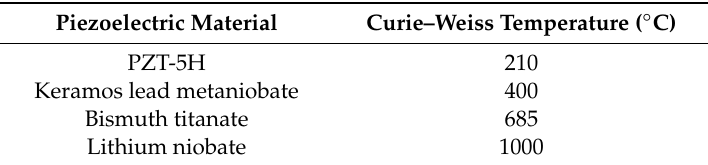
Table 1. Some well-known piezoelectrics